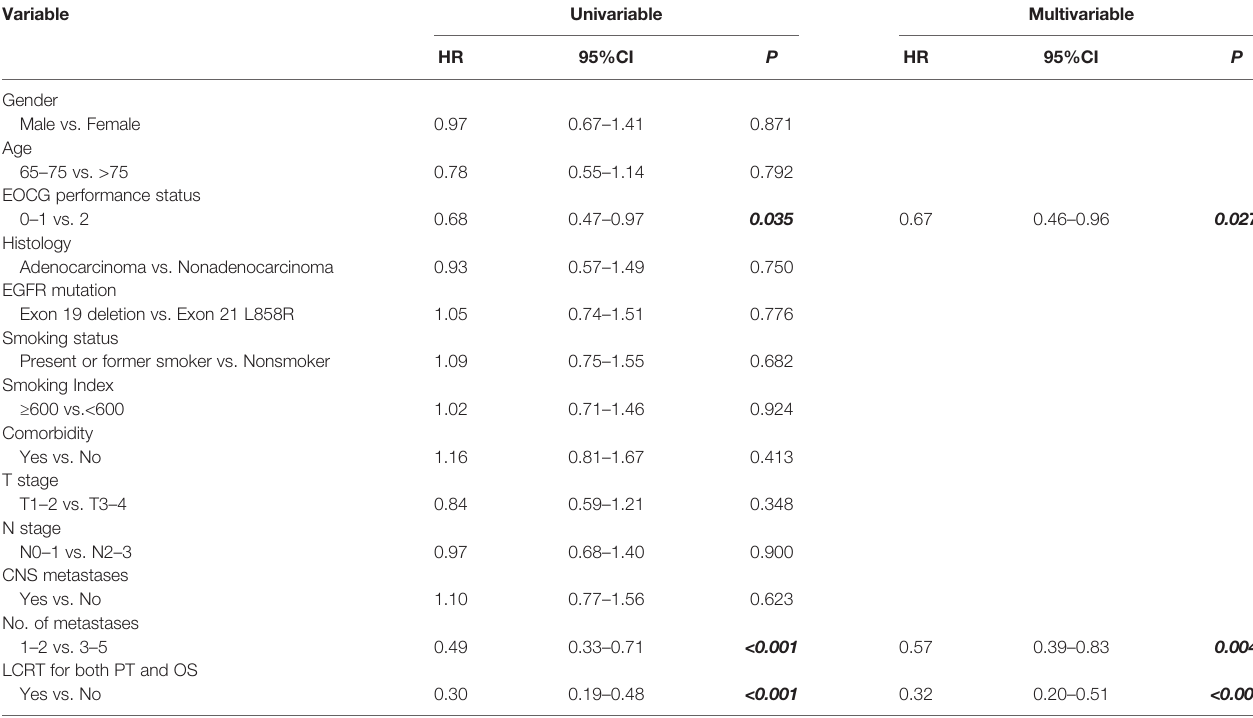
TABLE 4 | Factors associated with progress free survival in univariate and multivariate analyses.